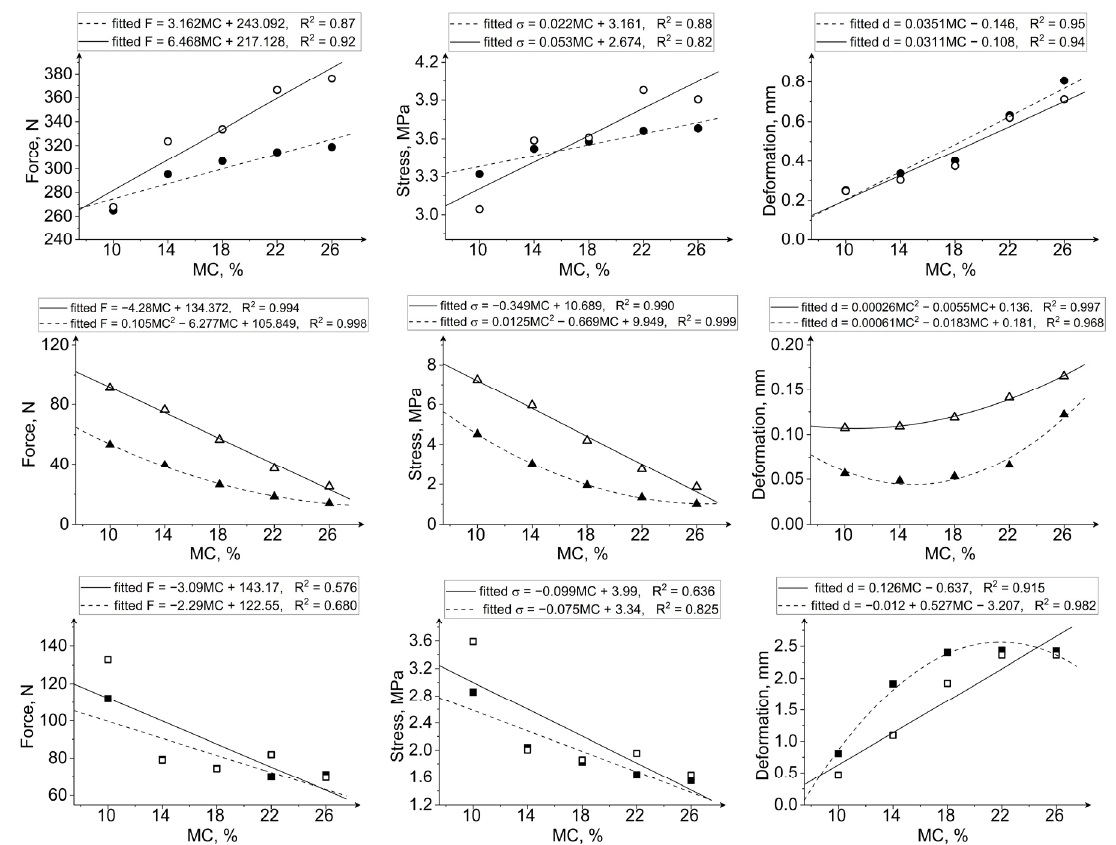
Figure 12. The dependencies between moisture content and selected mechanical properties for maize (circle), rice (triangle), and soybean (square) kernels at two loading rates: 1.25 mm/min (black) and 125 mm/min (white).